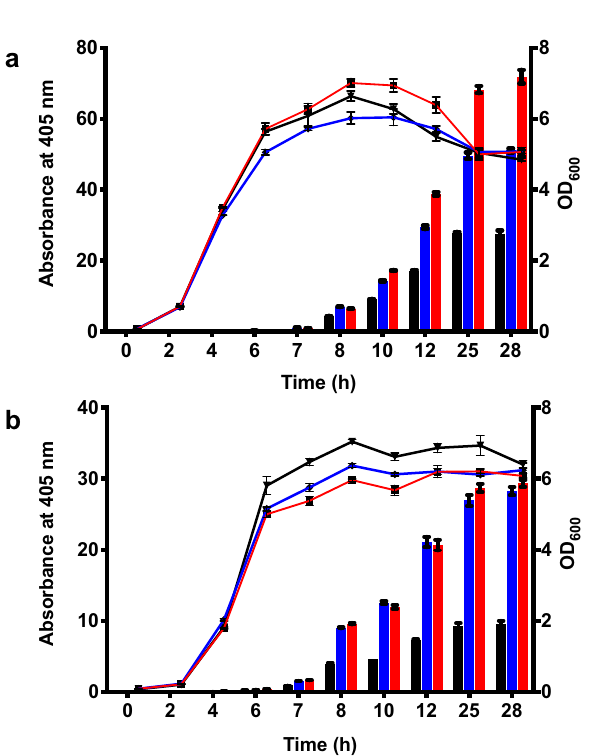
Figure 7. Protein secretion using OsmY(WT) and OsmY(M3) in ( a ) E. coli C41 (DE3) and ( b ) BL21(DE3). OsmY(WT)-Tfu0937 and OsmY(M3)-Tfu0937 were expressed using C41(DE3) and BL21(DE3) in 50-mL 2 × TY auto-induction media and at 37 °C and 250 rpm. Cultures were inoculated using 1:200 dilution. The cell optical densities monitored at 600 nm (right axis) are shown as lines. The activity of OsmY-Tfu0937 shown as bars was measured with the pNPG assay using an absorbance at 405 nm (left axis). The lines and bars of different variants are represented using different colours; OsmY(WT)—black, OsmY(TOA4)—blue and